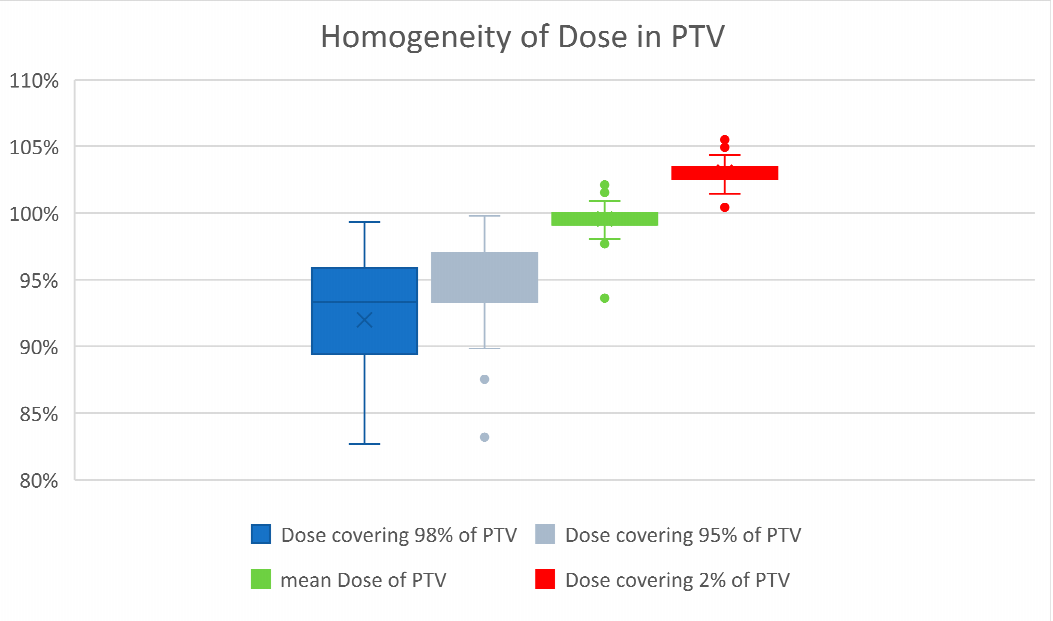
Figure 2. Dose maxima greater than 105% were carefully avoided because of the higher risk of developing fibrosis. The mean dose averaged 100%. The small boxes and short whiskers illustrate the consistent quality of treatment planning in patients.